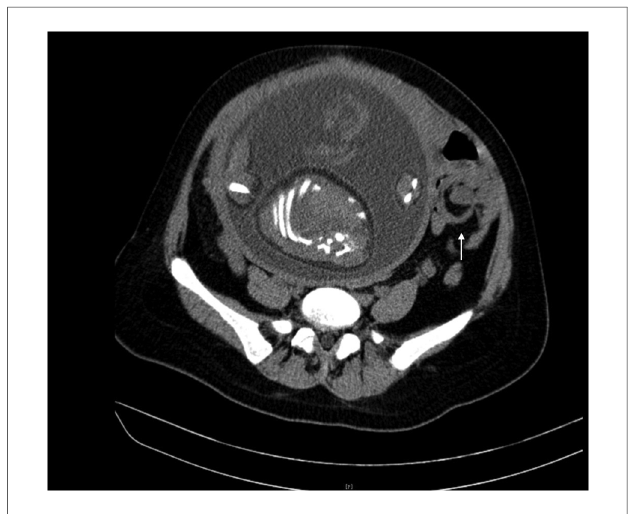
FIGURE 2 The left lower abdominal part of the small intestine was in a vortex shape in CT.